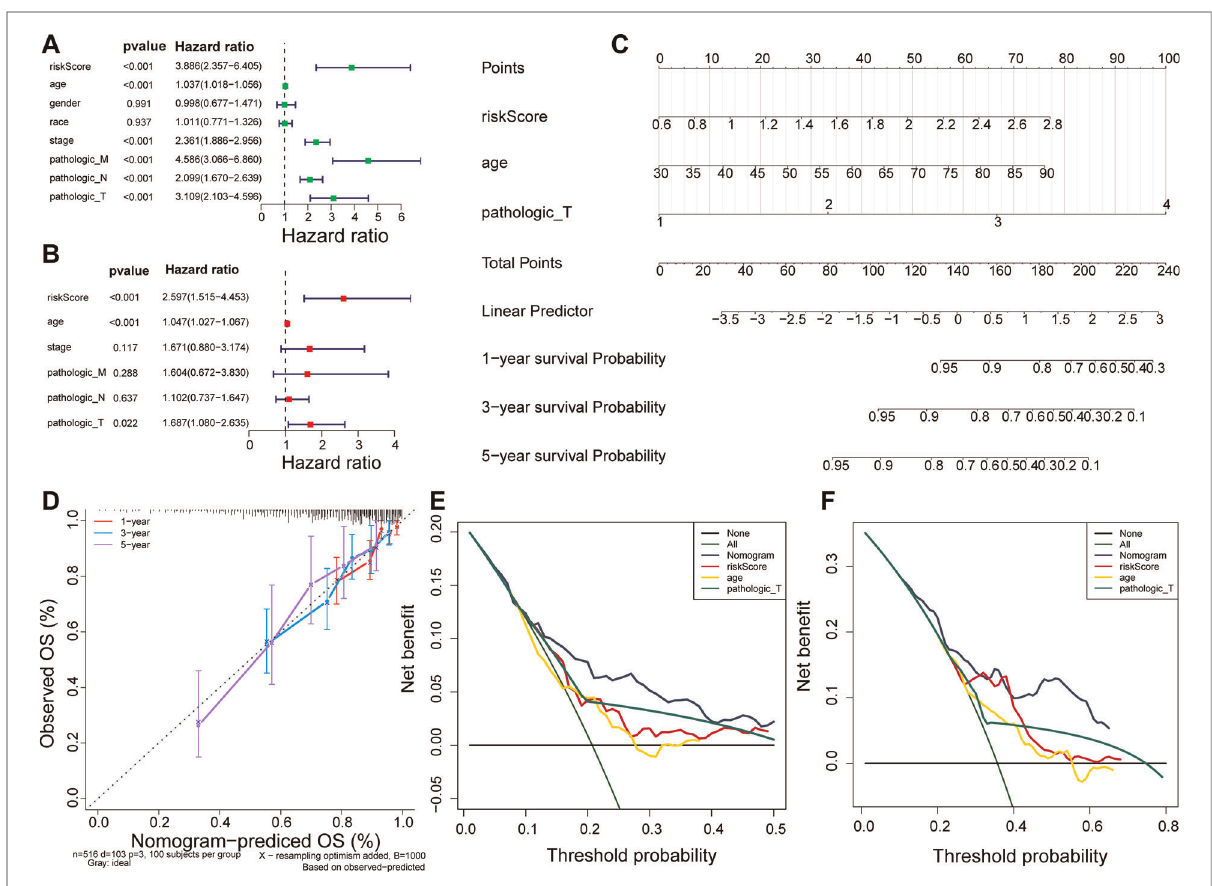
FIGURE 5 Nomogram predicting the OS of patients with CRC. ( A ) Univariate Cox regression analysis in TCGA cohort. ( B ) Multivariate Cox regression analysis in TCGA cohort. ( C ) Nomogram predicting patient survival at 1, 3, and 5 years. ( D ) Calibration curves of nomogram. ( E ) DCA curve for predicting 3-year survival of patients. ( F ) DCA curve for predicting 5-year survival of